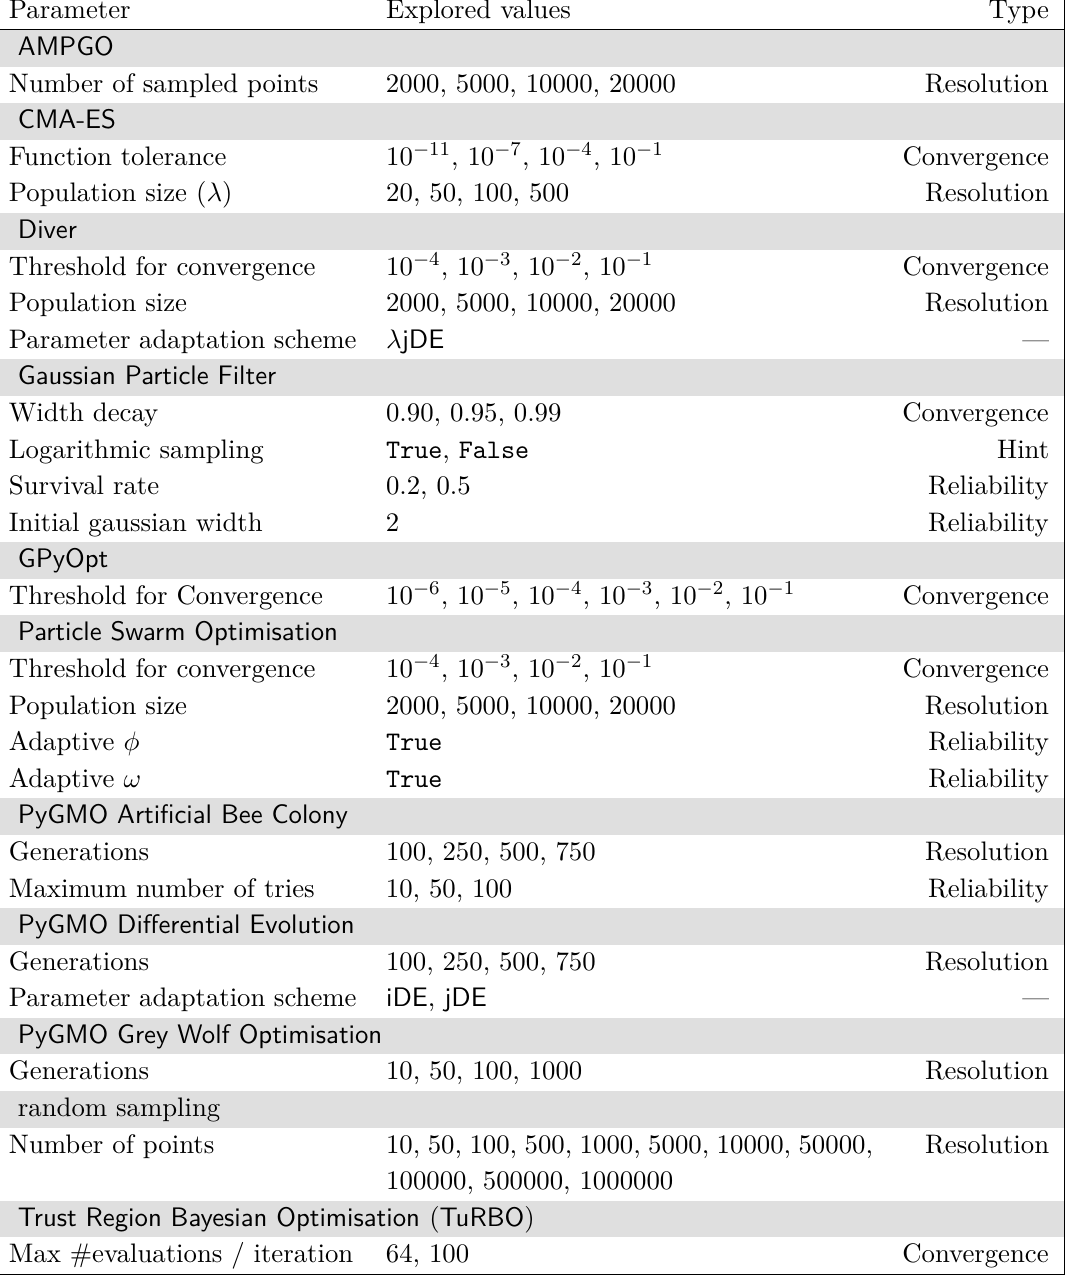
Table 1. A grouping of the various parameters of each of our optimisation techniques into the categories described in the main text. The explored values for these parameters can be found in the second